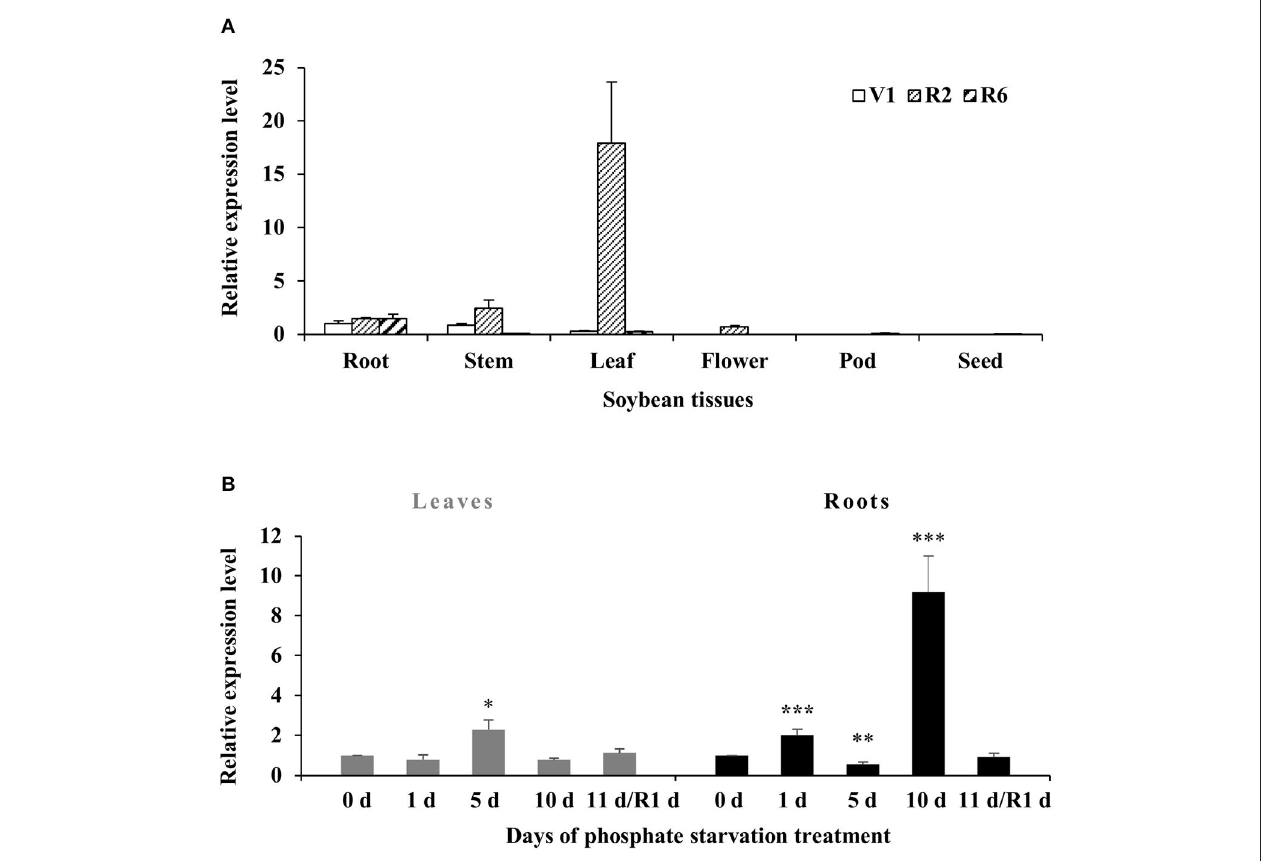
FIGURE 3 | Expression patterns of GmWRKY46 in soybean. (A) The expression of GmWRKY46 in roots, stems, leaves, flowers, pods, and seeds at the first trifoliate stage (V1), full bloom stage (R2), and full seed stage (R6). (B) Time course of the expression level of GmWRKY46 in leaves and roots. 0, 1, 5, 10, and 11 days, duration of Pi starvation (days); Recovery 11 days (R1d), 10 days of Pi starvation followed by 1 day on Pi-sufficient substrate. The expression level at 0h was set as 1, and data represented means ± SD of three replicates. Data significantly different from the corresponding controls were indicated (Student’s t -test, * P < 0.05; ** P < 0.01; *** P <